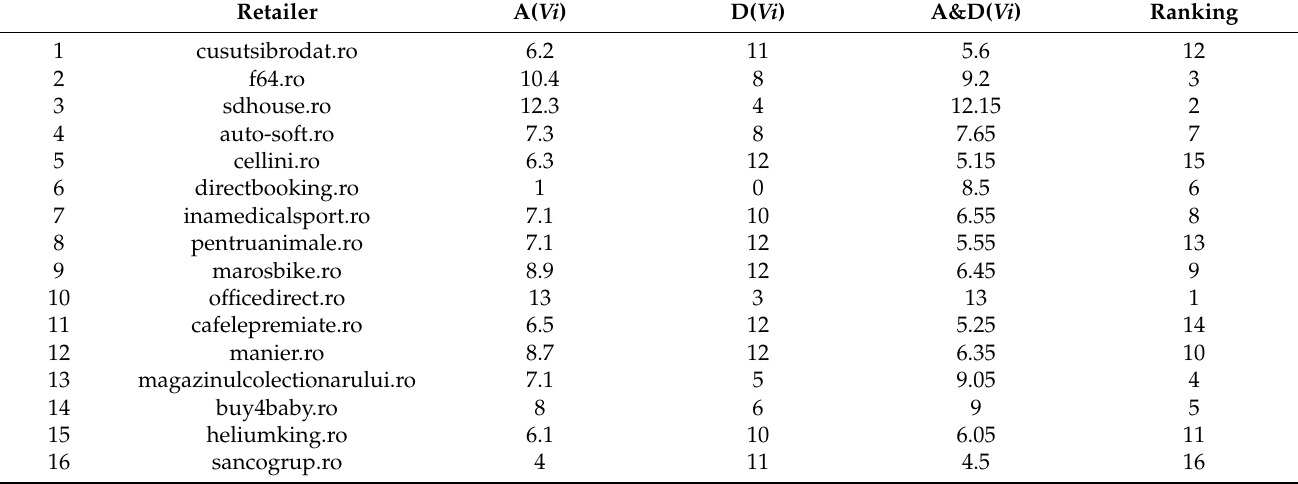
Table 8. Ranking based on Performance, Accessibility, Best Practices, and